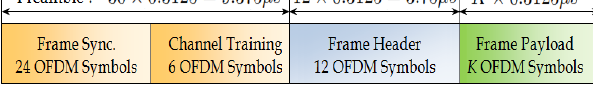
FIGURE 3: The MB - OFDM band groups through the ECMA - 368 standard.